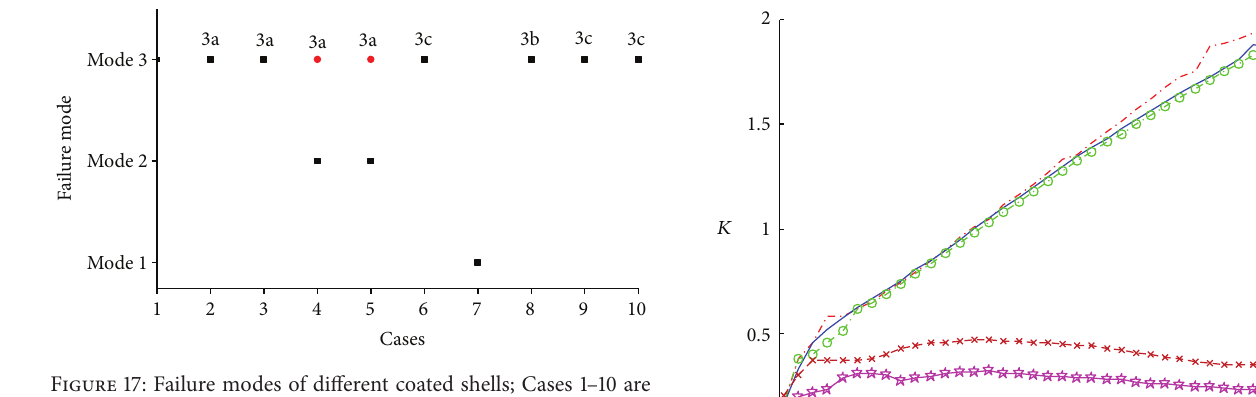
Figure 17: Failure modes of different coated shells; Cases 1–10 are shown in Table 10.